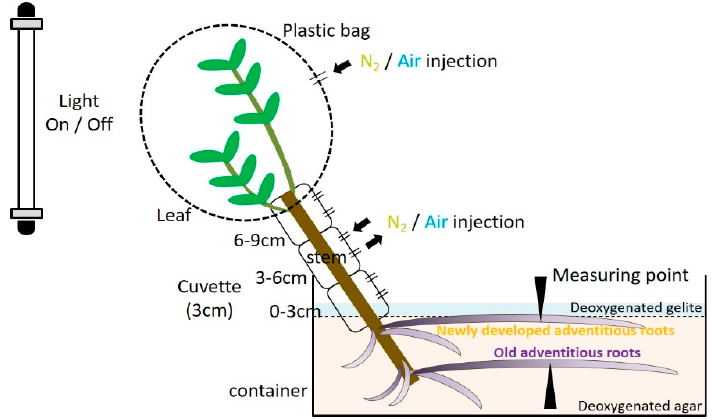
Figure 1. Diagram of the experiment. Air and N 2 injected 0–3, 3–6, and 6–9 cm above the water surface(arrows). A plastic bag was attached to restrict oxygen to each part of the stem and leaf. The root system was embedded in deoxygenated agar to restrict oxygen. Changes in the oxygen partial pressure (pO 2 ) were measured using a Clark-type O 2 microelectrode(arrowheads) in adventitious roots.